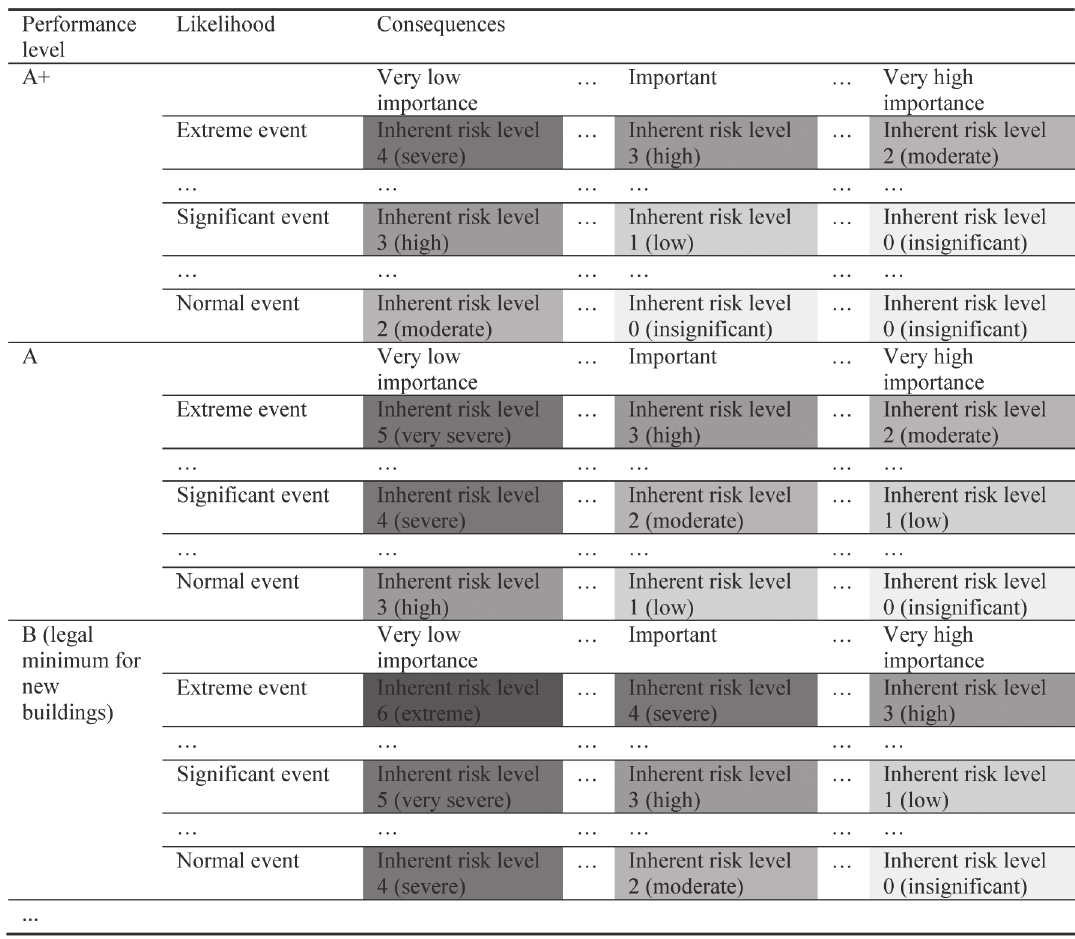
Table 2. Correspondence between levels of structural performance and levels of inherent technical